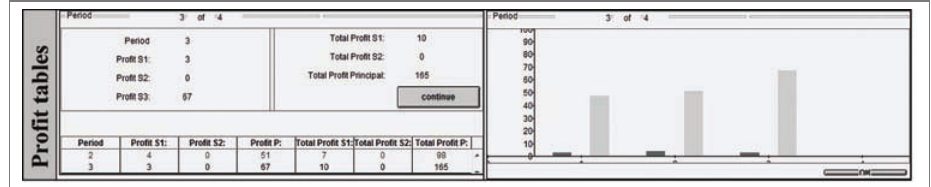
Fig. 3. Present round’s profit, total profit and profit history listing (left) and bar chart depiction